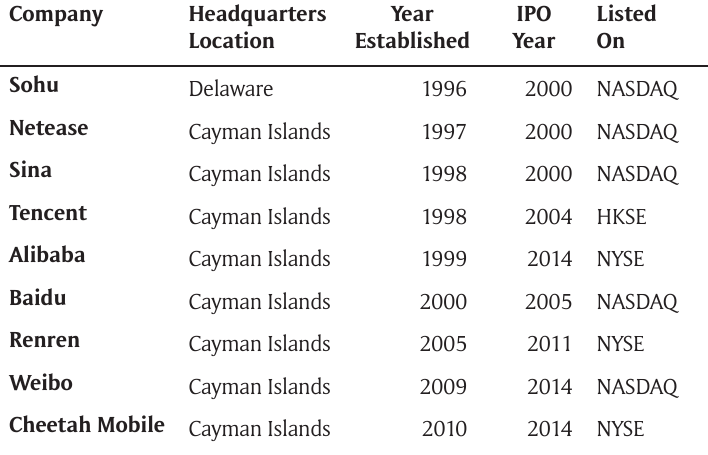
Table 1: Public listing of Chinese Internet